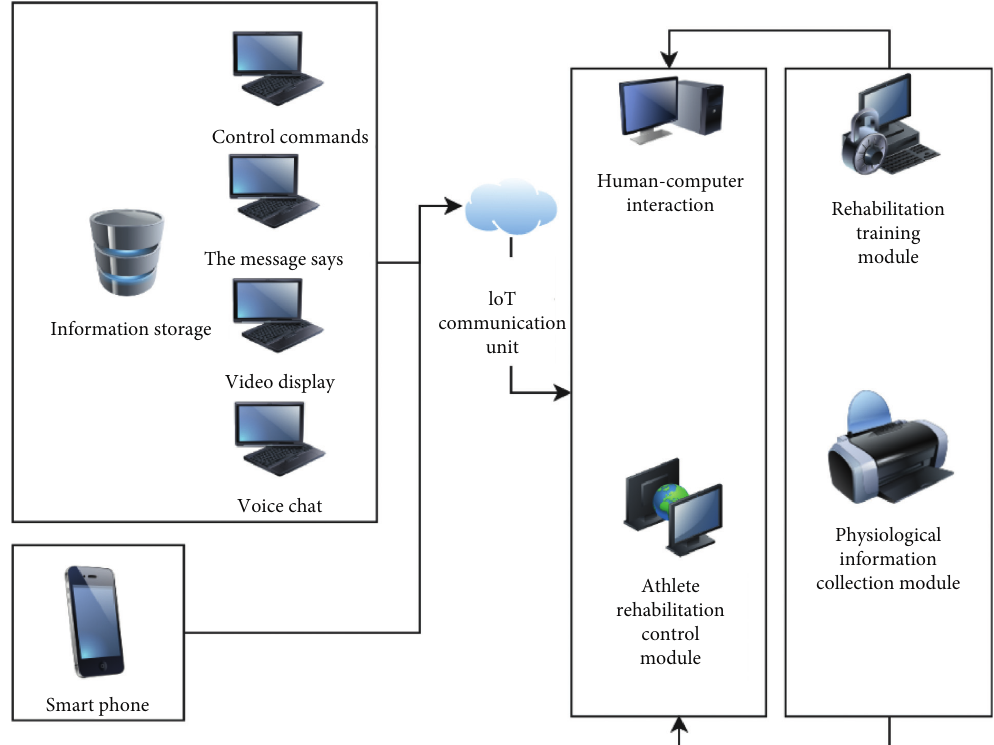
Figure 15: Functional block diagram of the remote interactive system.